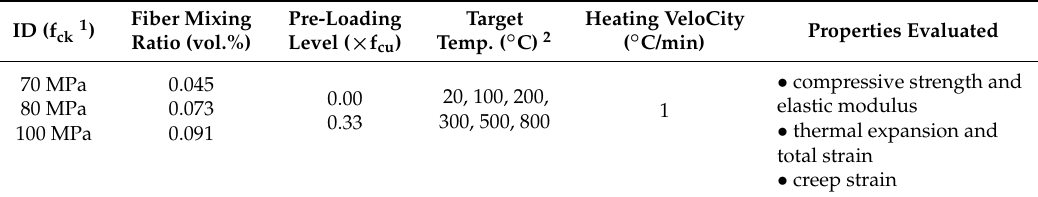
Table 1. Experimental conditions.